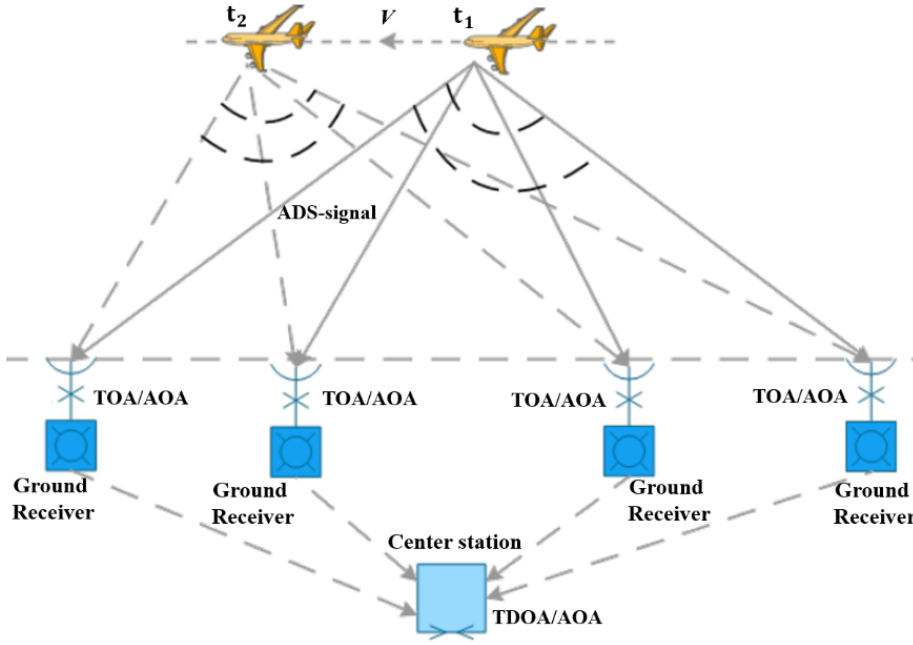
Figure 20. Geometry distribution of static sensors and moving targets in the simulation